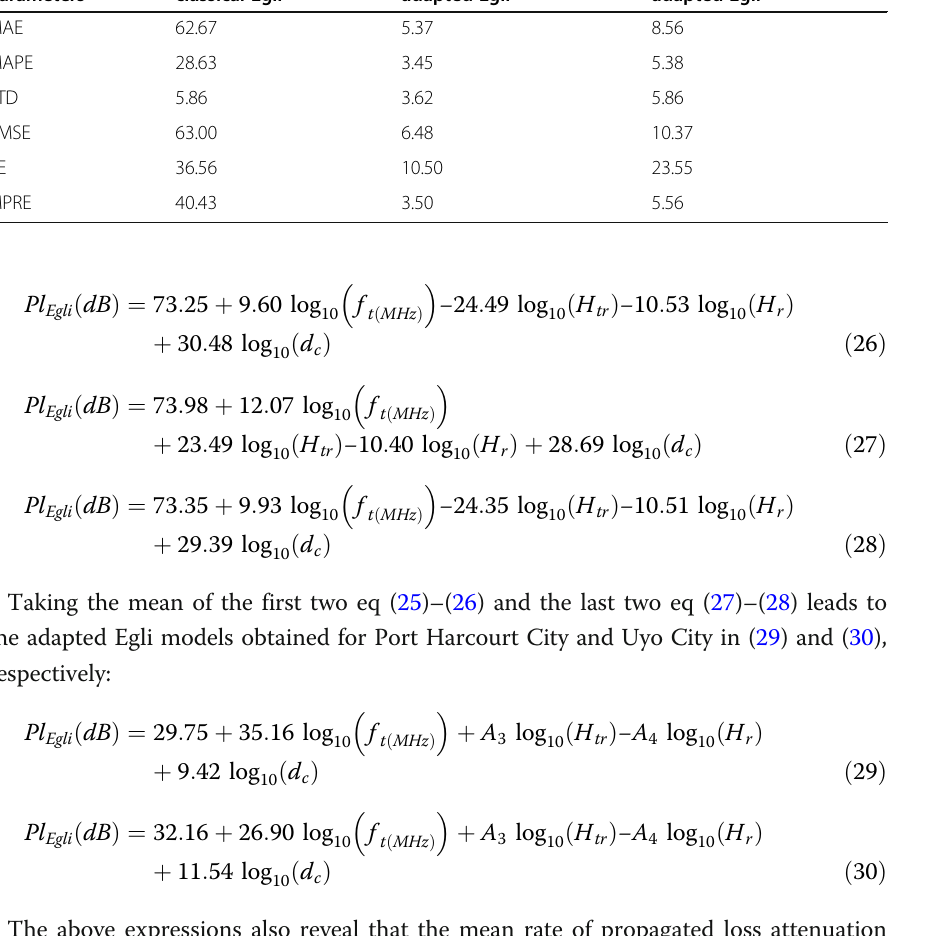
Table 3 Computed first order estimates statistics for Cell_1 Error estimation Estimation error with parameters classical Egli